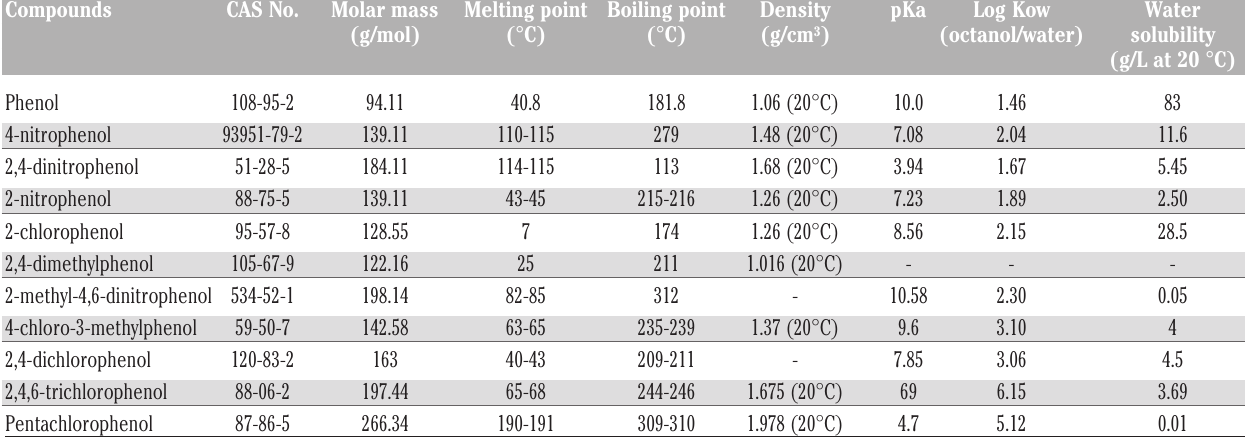
Table 1. Physical properties of priority phenolic compounds. 15 Compounds CAS No.